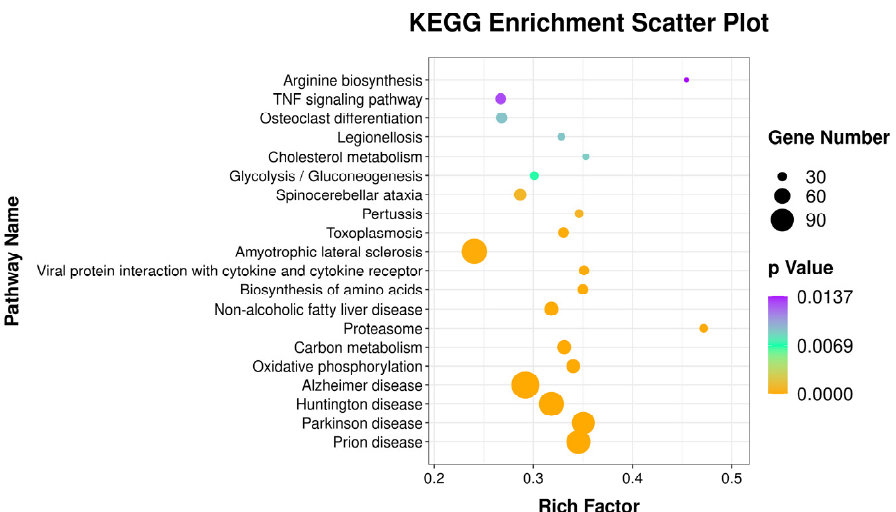
Figure 8. First 20 KEGG-enriched pathways, calculated numbers of DEGs in each pathway, and rich factors and p values. Gene numbers were represented by the size of the dots. The color of the dot went from yellow to purple, indicating the p -value went from small to large.